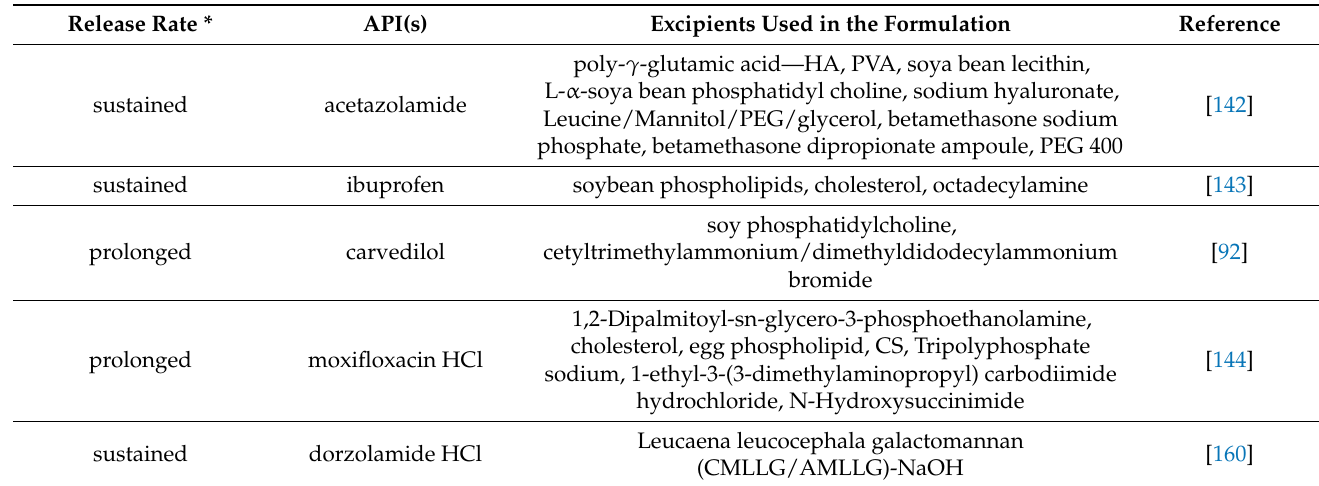
Table 4. An overview of the excipients used in modified release ocular formulations (nanotechnology).